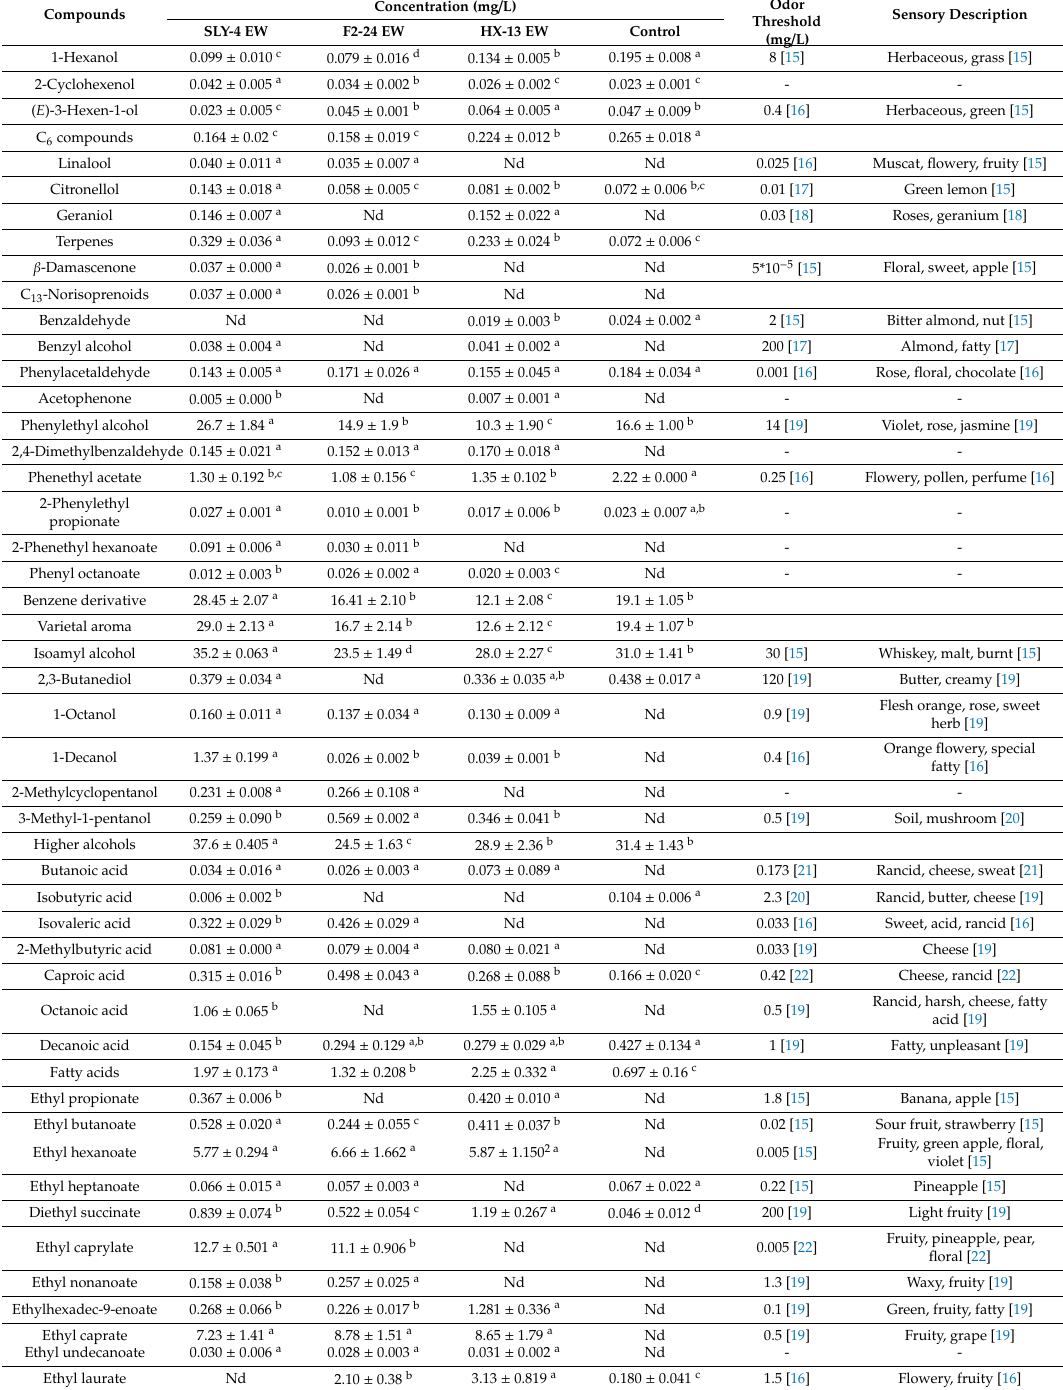
Table 1. Contents of volatile compounds detected in sample wines by